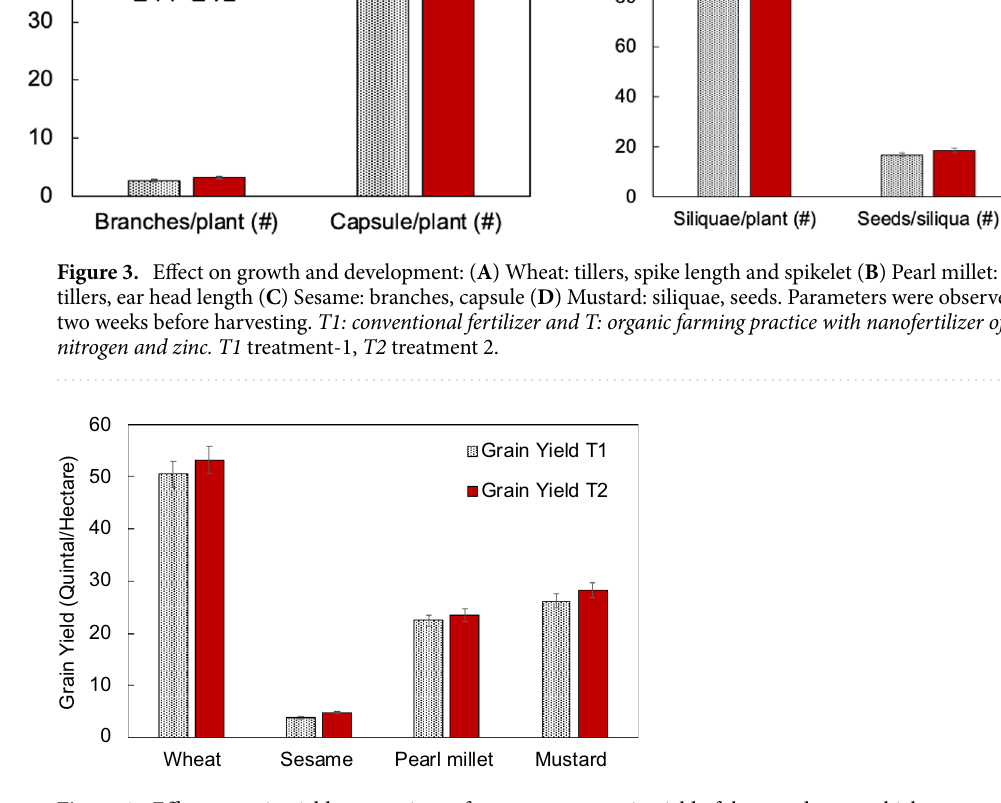
Figure 4. Effect on grain yield: comparison of treatments on grain yield of the tested crops which were grown under field condition with the treatments T1: conventional fertilizer and T: organic farming practice with nanofertilizer of nitrogen and zinc. T1 treatment-1, T2 treatment